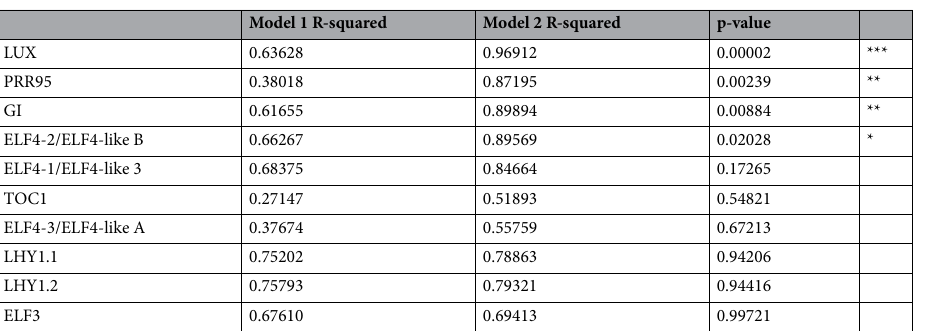
Table 3. Statistical test of the effect of three parameters (lighting regime, water status and plant organ) on the mean relative transcript amount of Brachypodium core clock genes. Model 1: linear model; Model 2: linear model with interacting factor. R-squared means the coefficient determination that indicates the fitting quality of the model. Values are statistically different (p < 0.05 by T-test ANOVA) if interaction between the parameters is predicted. p < 0.05 indicates a significant difference between the two